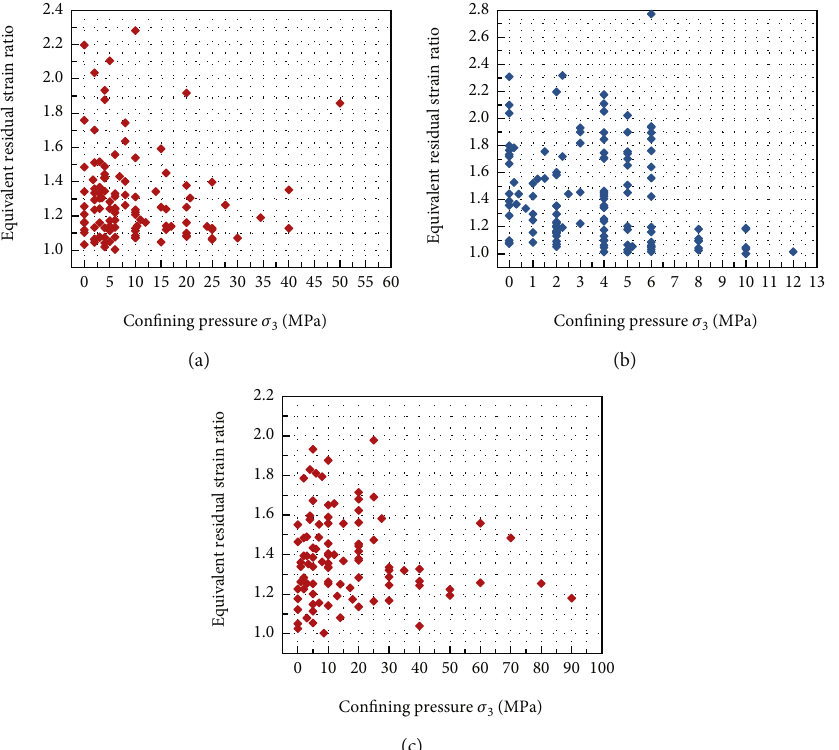
Figure 9: Relationship between the equivalent residual strain ratio and con fi ning pressure: (a) raw coal, (b) briquette composed of soft coal, and (c) soft rock.